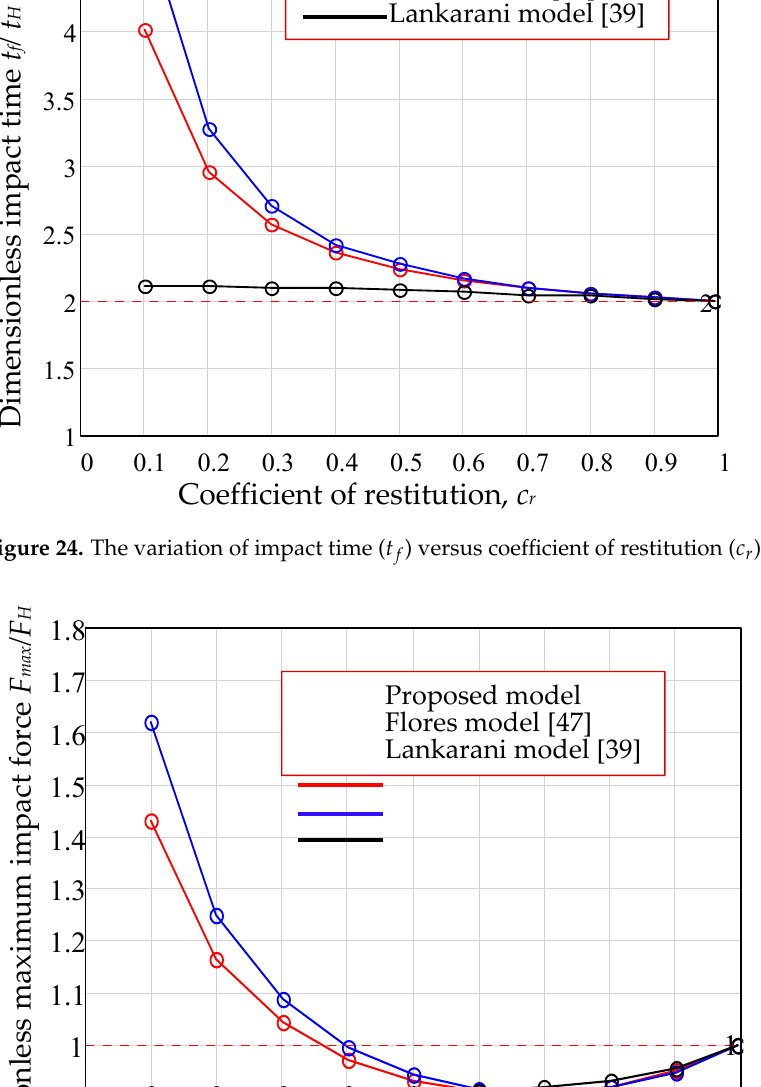
Figure 23. The variation of maximum approach ( 𝑥 (cid:3040) ) versus coefficient of restitution ( 𝑐 (cid:3045) ).